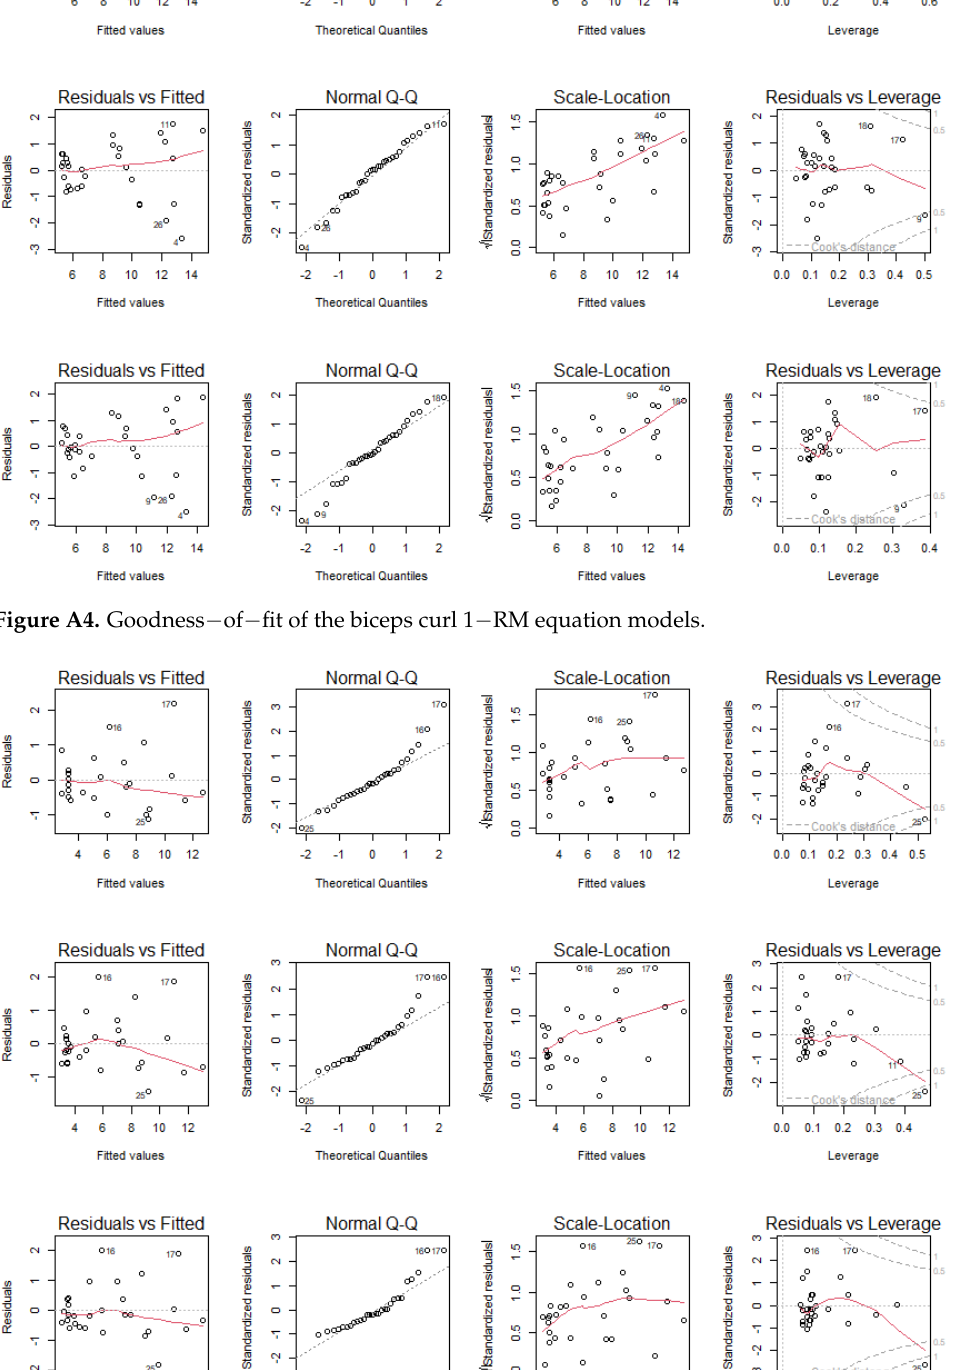
Figure A5. Goodness − of − fit of the overhead triceps extension 1 − RM equation models.